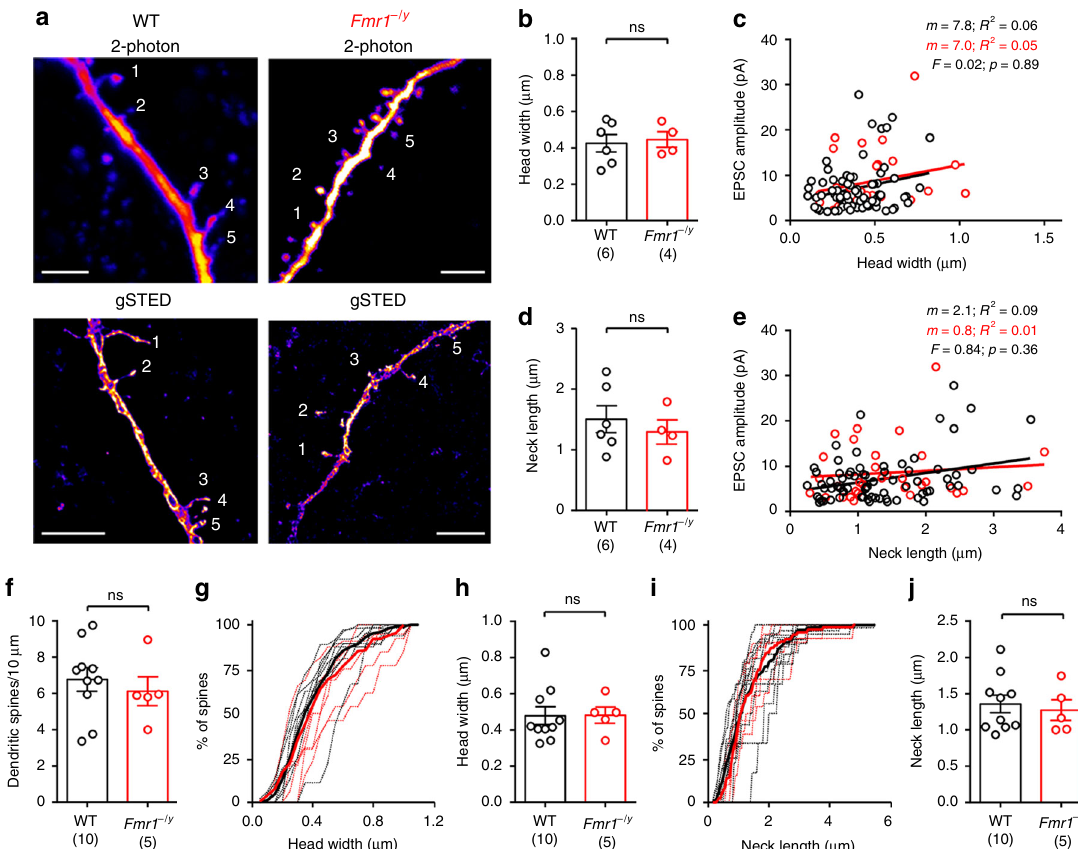
Fig. 3 Dendritic spines show no difference in nanoscale morphology, or structure – function relationship. a Dendrites from WT (left) and Fmr1 − /y (right) mice under 2-photon microscopy (top), then post hoc STED imaging (bottom). Scale bar: 5 µ m. b Average spine head width in WT (black) and Fmr1 − /y (red) mice (WT: 0.43±0.05; Fmr1 − /y ; 0.45±0.04; d.f.: 8; t = 0.29; p = 0.78, T-test). Number of mice is indicated. c Comparison of spine head width and uEPSC amplitude (comparing slope: d.f.: 1, 100; F = 0.02; p = 0.89). WT spines showed a positive correlation (d.f.: 70, F = 4.27, p = 0.042, F-test). d Average spine neck length (WT: 1.52±0.22; Fmr1 − /y ; 1.31±0.20; d.f.: 8; t = 0.66; p = 0.53, T-test). e Comparison of spine neck-width and uEPSC amplitude (Slope: WT: 2.1±0.8; Fmr1 − /y ; 0.8±1.4; d.f.: 1, 101; F = 0.84; p = 0.36; F-test). f Spine density on L4 SCs (WT: 6.8±0.7spines/10 µ m; Fmr1 − /y : 6.1±0.80spines/10 µ m; d.f.: 13; t = 0.60; p = 0.56; T-test). g Distribution of non-uncaged spine head-widths, as an average of all mice (bold) and individual mice (dashed). h Average head width of non- uncaged spines (WT: 0.48±0.05 µ m; Fmr1 − /y : 0.48±0.04 µ m; d.f.: 13; U = 20.0; p = 0.59; Mann – Whitney U -test). i Distribution of spine neck length of non- uncaged spines. j Average of spine neck length in non-uncaged spines (WT: 1.36±0.12 µ m; Fmr1 − /y : 1.27±0.14 µ m; d.f.: 13; U = 20.0; p = 0.55; Mann – Whitney U -test). Statistics shown: ns p >0.05 from unpaired t -test ( b , d , f , h , j ) and sum-of-least-squares F-test ( c , e ). All data are shown as mean±SEM and source data for all plots are provided as a Source Data fi le